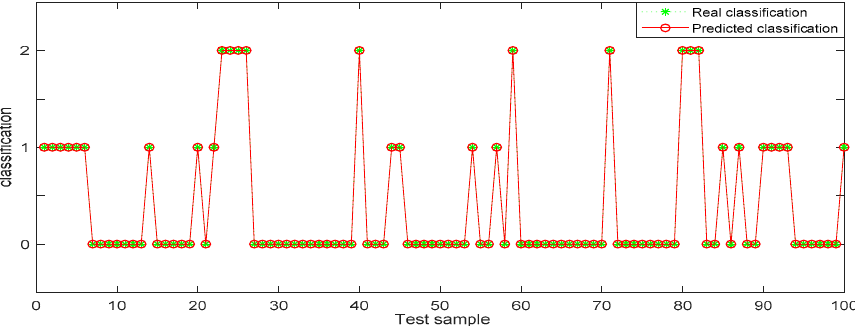
Figure 10. BP (back propagation) neural network recognition results from dataset 3.